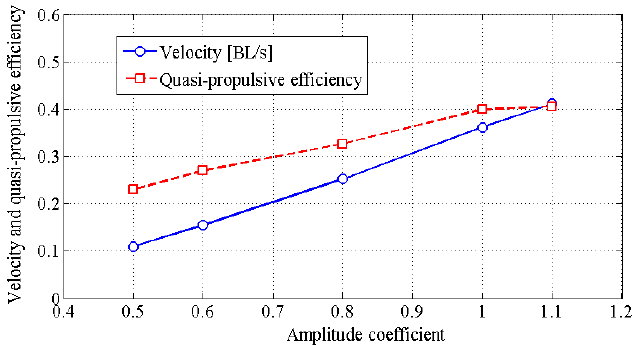
Figure 16. Effects of amplitude coefficient on the swimming performance of carangiform fish.